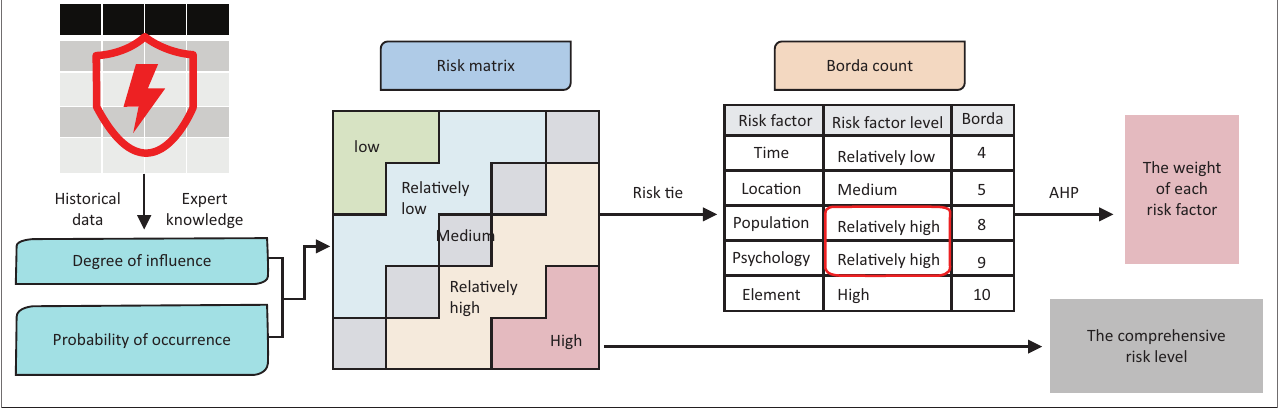
FIGURE 2: Method of evaluating the risk level of